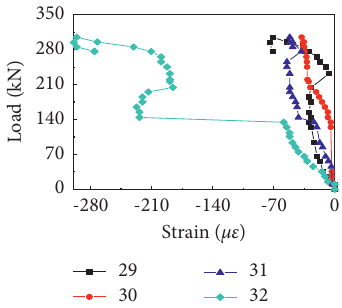
Figure 22: Load-strain curves at measuring points 29 to 32 of test piece 3-A.